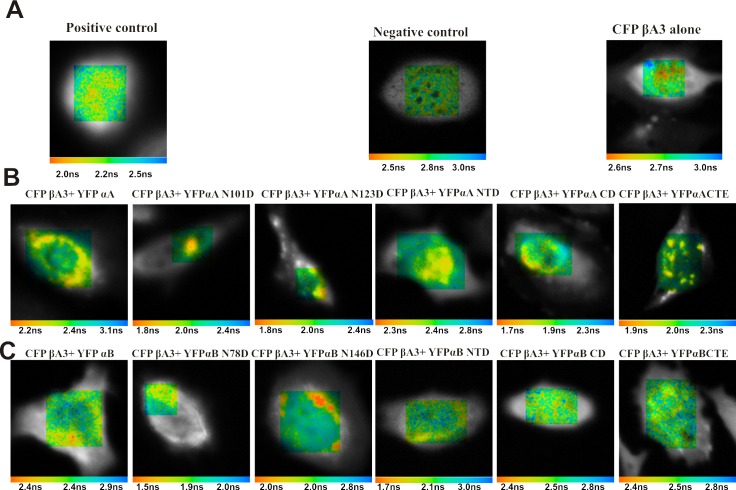
FLIM FRET images of HeLa cells showing life-time of the CFP βA3- crystallin in the presence of acceptor proteins (WT αA- and WT αB-crystallins and their deamidated and domain mutants).FRET measurement by fluorescence life time imaging microscopy of the HeLa cells transfected with A. Positive (YFP-CFP fusion), negative (CFP and YFP co-transfected) controls and CFP βA3-crystallin B. Co-transfected with CFP βA3-crystallin and YFP WT αA-crystallin and its mutants C. Co-transfected with CFP βA3-crystallin and YFP WT αB-crystallin and its mutants. The images were taken with Becker and Hickl FLIM system attached with the confocal miroscope. The life-time images are shown in pseudocolours (nanoseconds). The apparent mean life-time™ for each image is shown in the center at the bottom of each image.